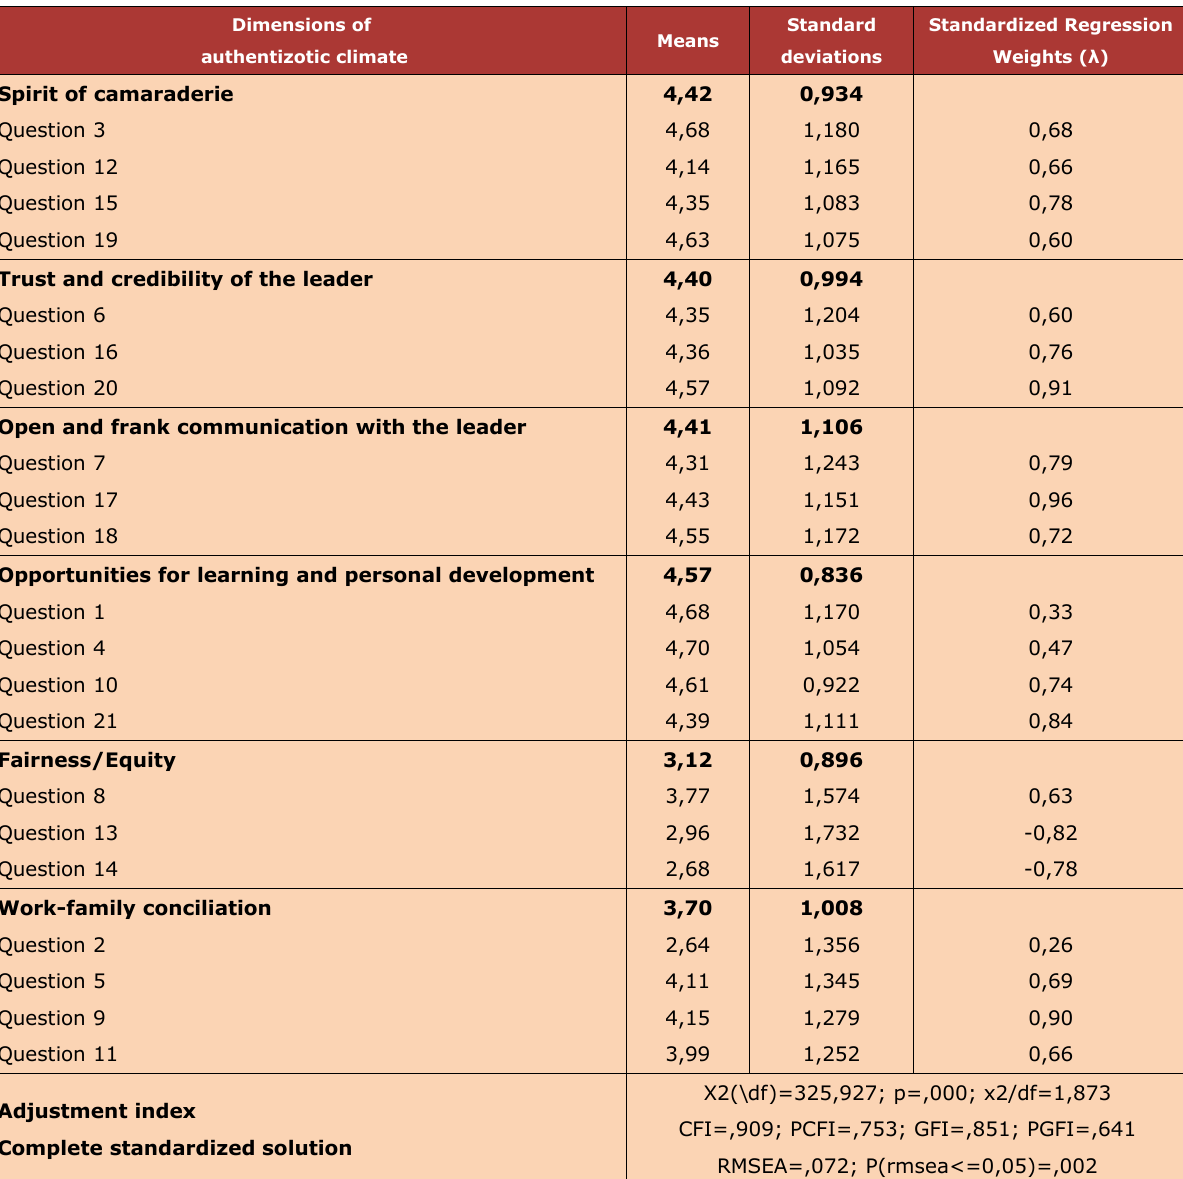
Table 4. Authentizotic organizational dimensions. Confirmatory factor